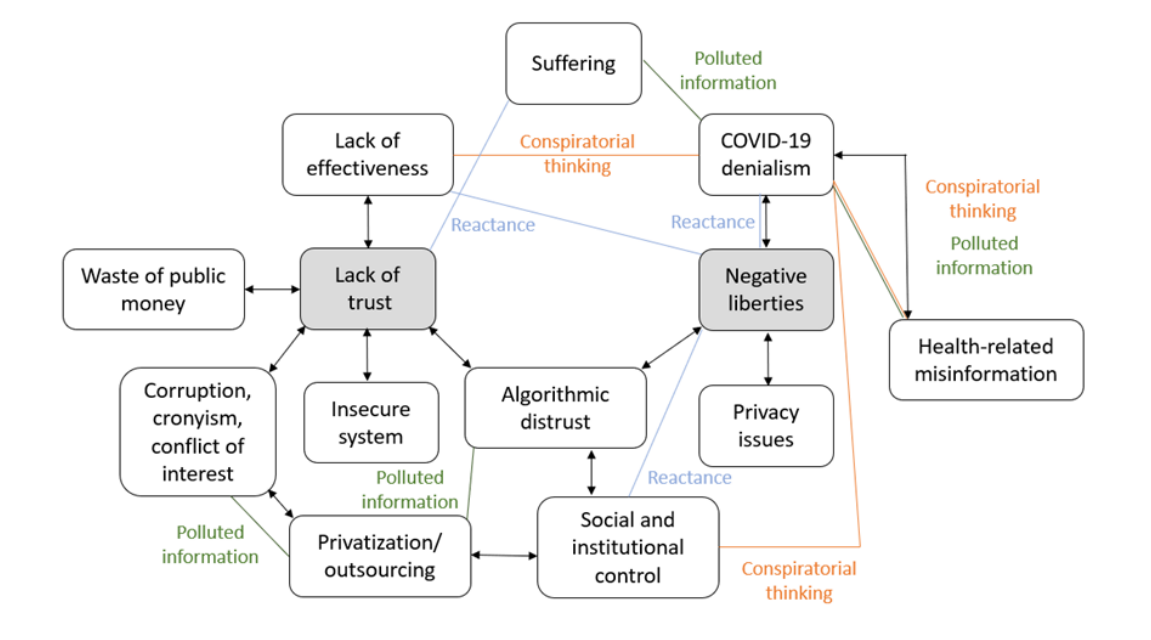
Figure 4. Conceptual